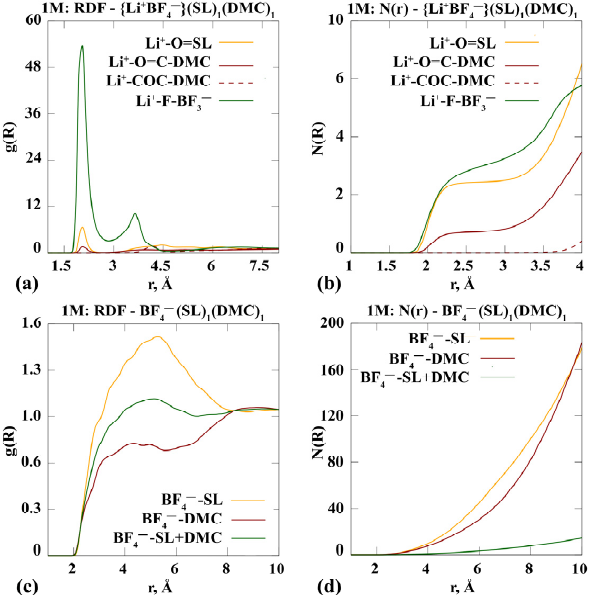
Figure 2. Radial distribution function g(R) ( a , c ) and statistical structural factor N(R) ( b , d ) for a system modelling a 1 m {Li + BF 4 − } in (SL) 1 (DMC) 1 (1:1, vol.). modelling a 1 m {Li + BF − } in (SL) 1 (DMC) 1 (1:1, 4